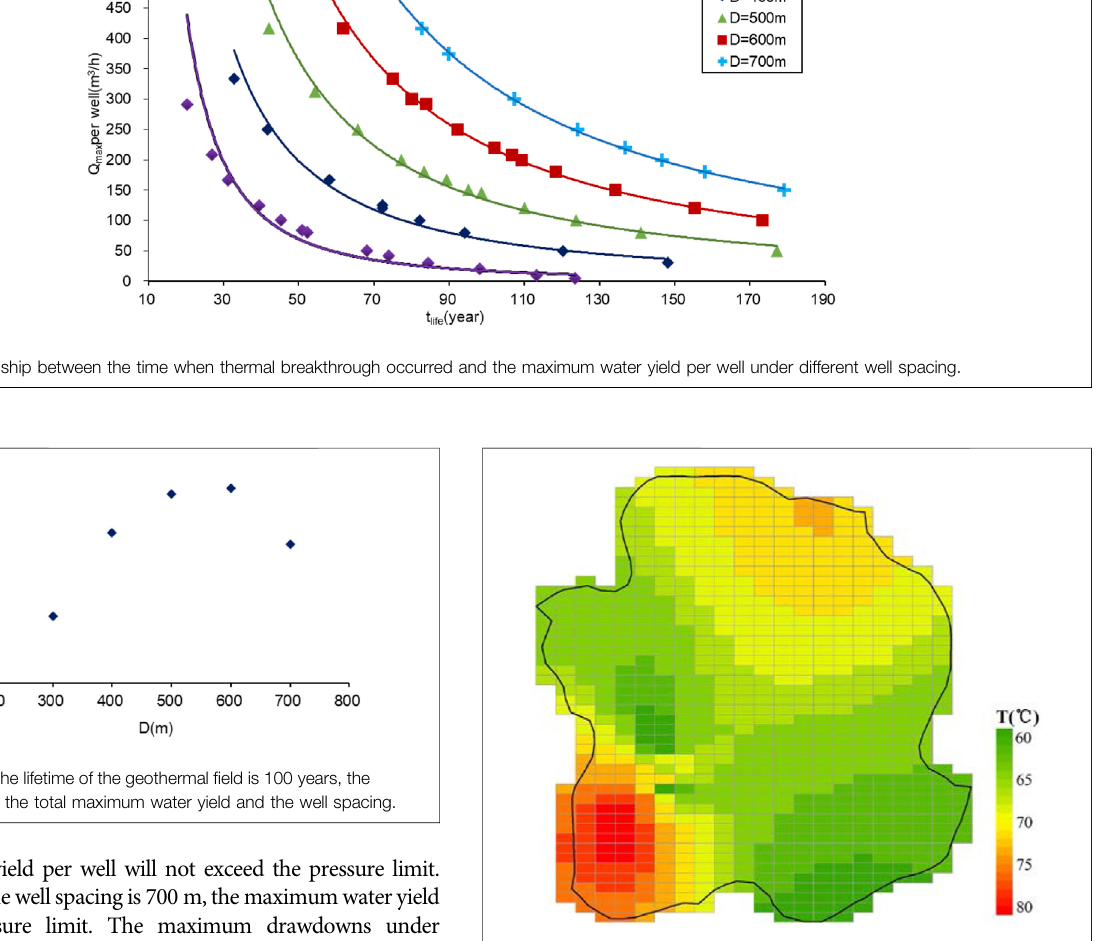
FIGURE 11 | The study area is divided into several rectangles and the reservoir temperature distribution in the Jixian reservoir is superimposed.